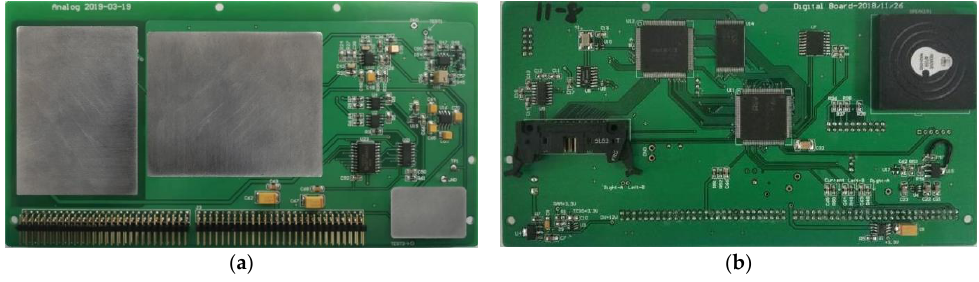
Figure 3. JOM-4S OVM.